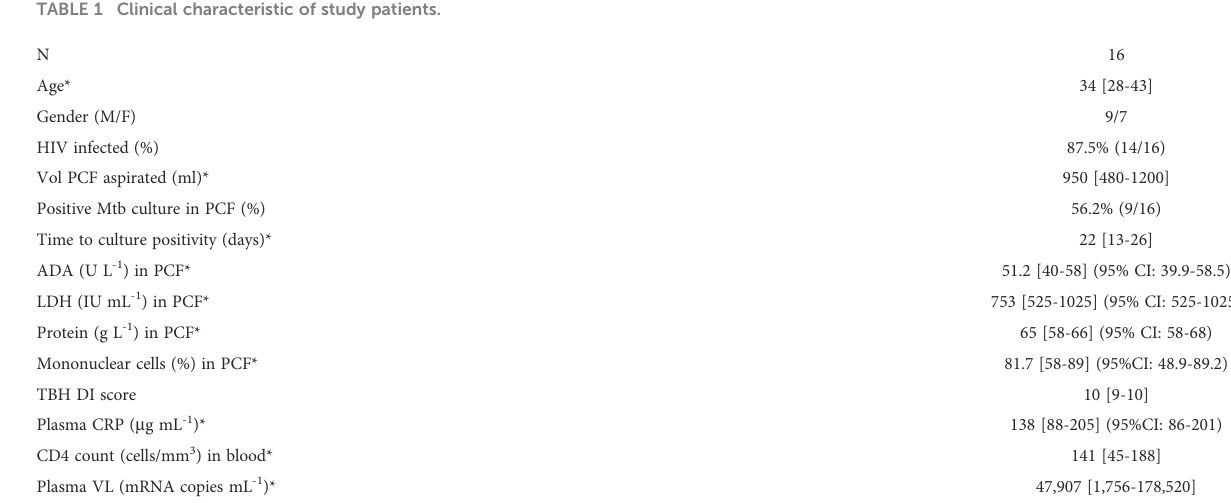
TABLE 1 Clinical characteristic of study